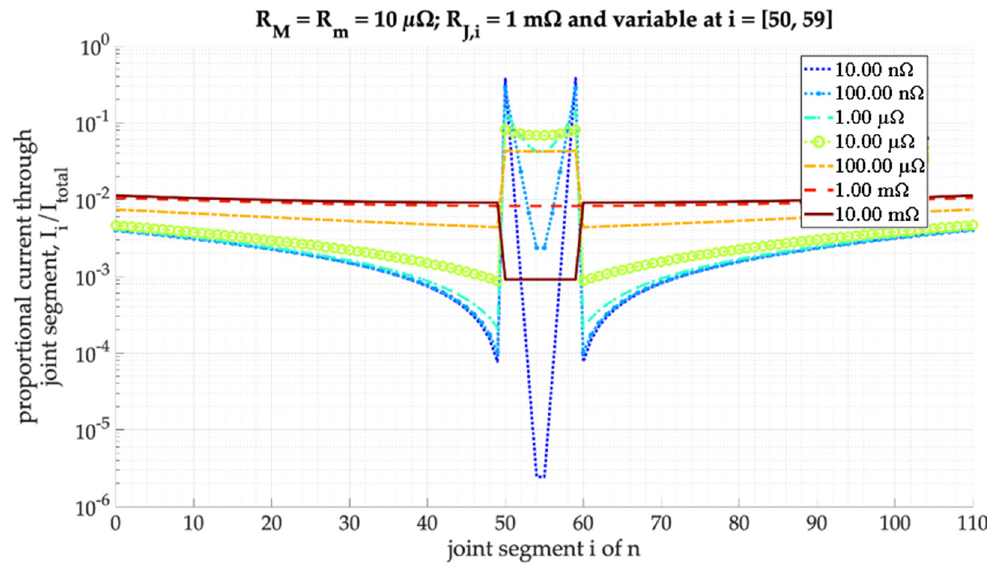
Figure 4. Simulation of current through a simplified model with a central weld seam.